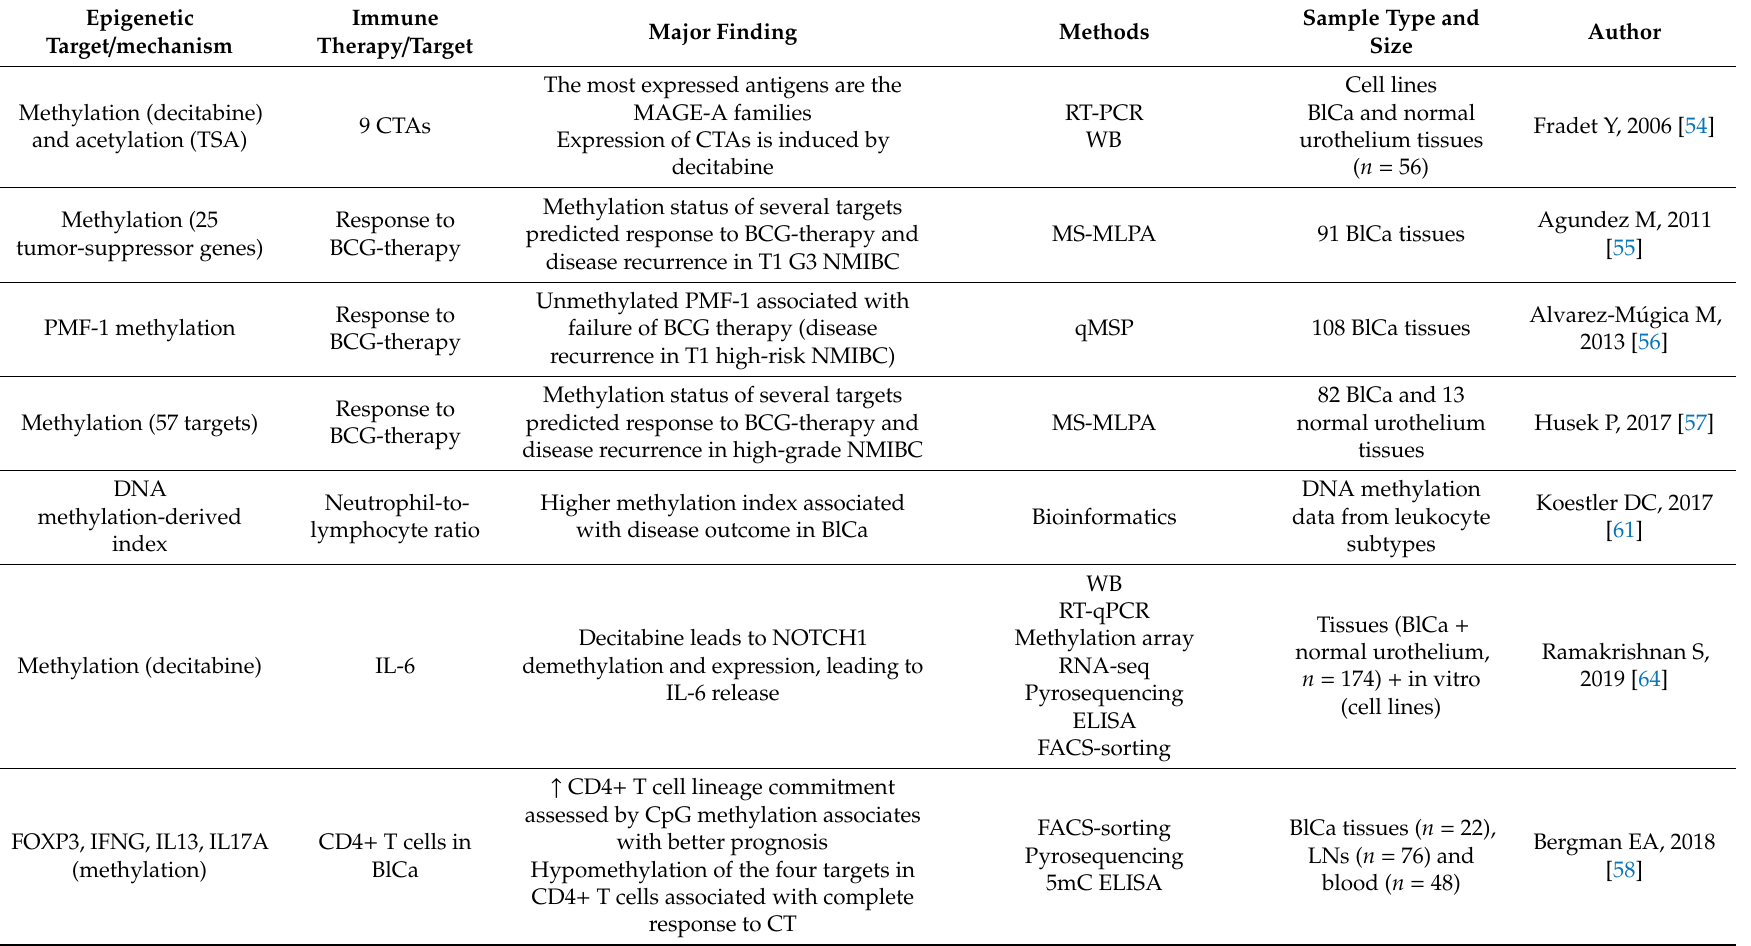
Table 1. Immunoepigenetic-based studies in bladder